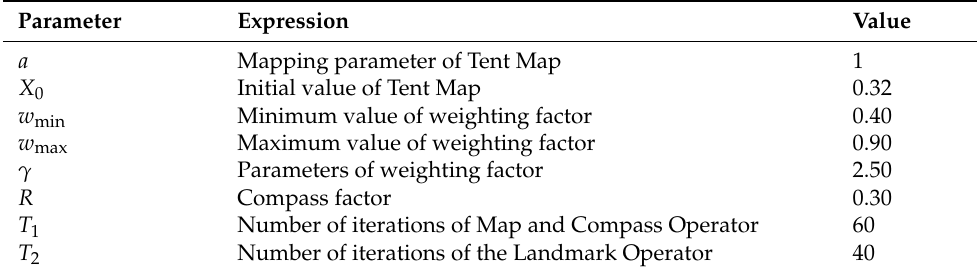
Table 1. Parameters for initialization of the algorithm.